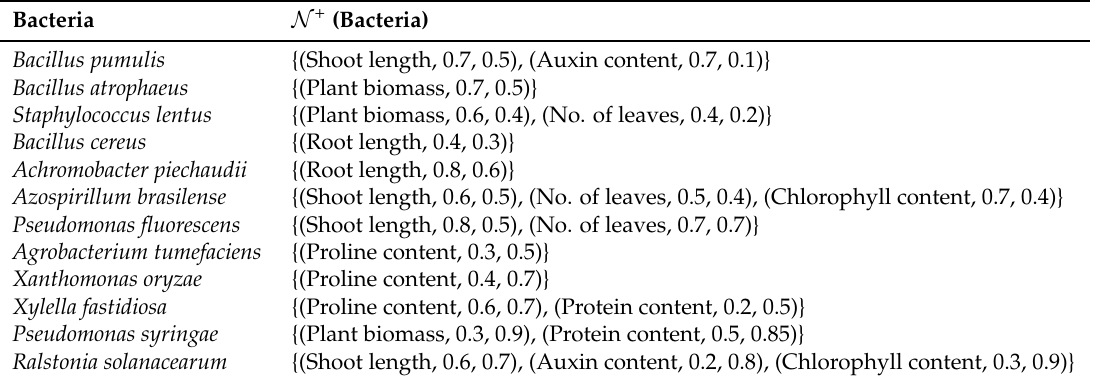
Table 3. Pythagorean fuzzy out-neighborhoods of